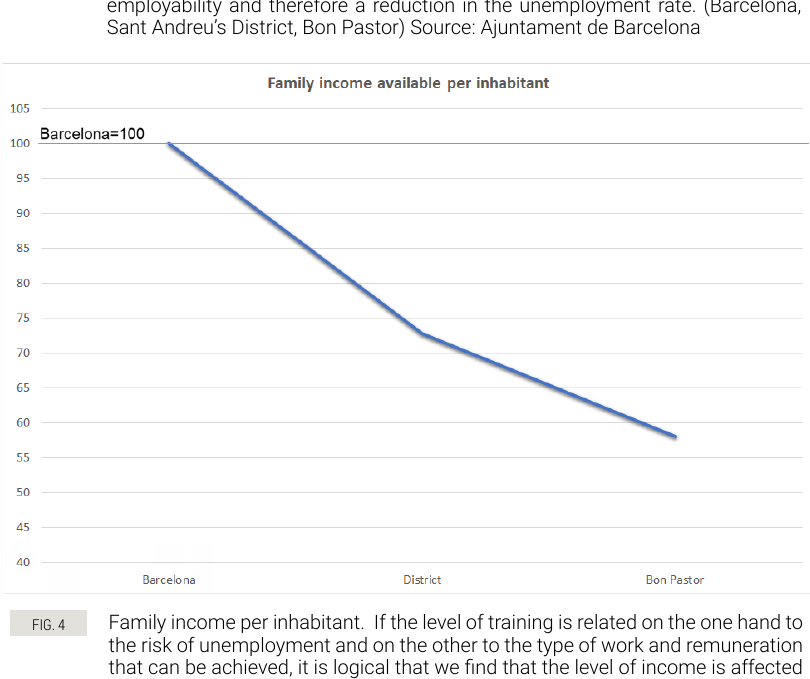
FIG. 3 % of registered unemployment. Barcelona and its metropolitan area are an emi- nent area of services (tertiary, quaternary and quinary), a part with high added value, and another based on “garbage” jobs. Access to education ensures better employability and therefore a reduction in the unemployment rate. (Barcelona, Sant Andreu’s District, Bon Pastor) Source: Ajuntament de